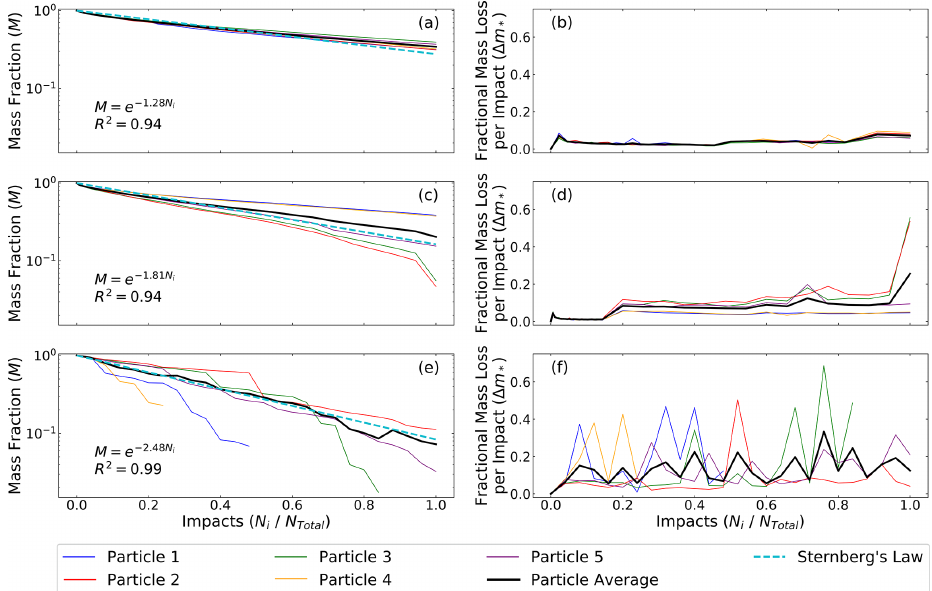
Figure 6. Mass loss parameters over the course of rotation experiments. Figures to the left show changes in mass fraction, M , for (a) A b = 1.1 × 10 − 2 s 2 m − 2 (80% VCM), (c) A b = 9.3 × 10 − 3 s 2 m − 2 (50% VCM), and (e) A b = 1.9 × 10 − 3 s 2 m − 2 (16.7% VCM). Fig- ures to the right show fractional mass loss per impact, (cid:49)m ∗ , for the same materials in panels (b) , (d) , and (f) . All five particles of a given composition are represented on each plot, with the average ( n = 5) depicted as a thicker black line. The number of impacts undergone by each particle has been normalized by the total number of impacts to allow comparison – mechanically strong particles in panels (a, b) underwent 4400 drops, panels (c, d) underwent 3500 drops, and mechanically weak particles in panels (e, f) underwent 25 drops. These weak particles, represented at the bottom of the figure, lost significant amounts of mass during each rotation and continued to be placed in the drum until very little of the original particle remained. Additionally, Sternberg’s law – denoted by the dashed cyan line – was fit to each plot of mass fraction. Mass fraction scales exponentially with the number of impacts in the rotating drum.